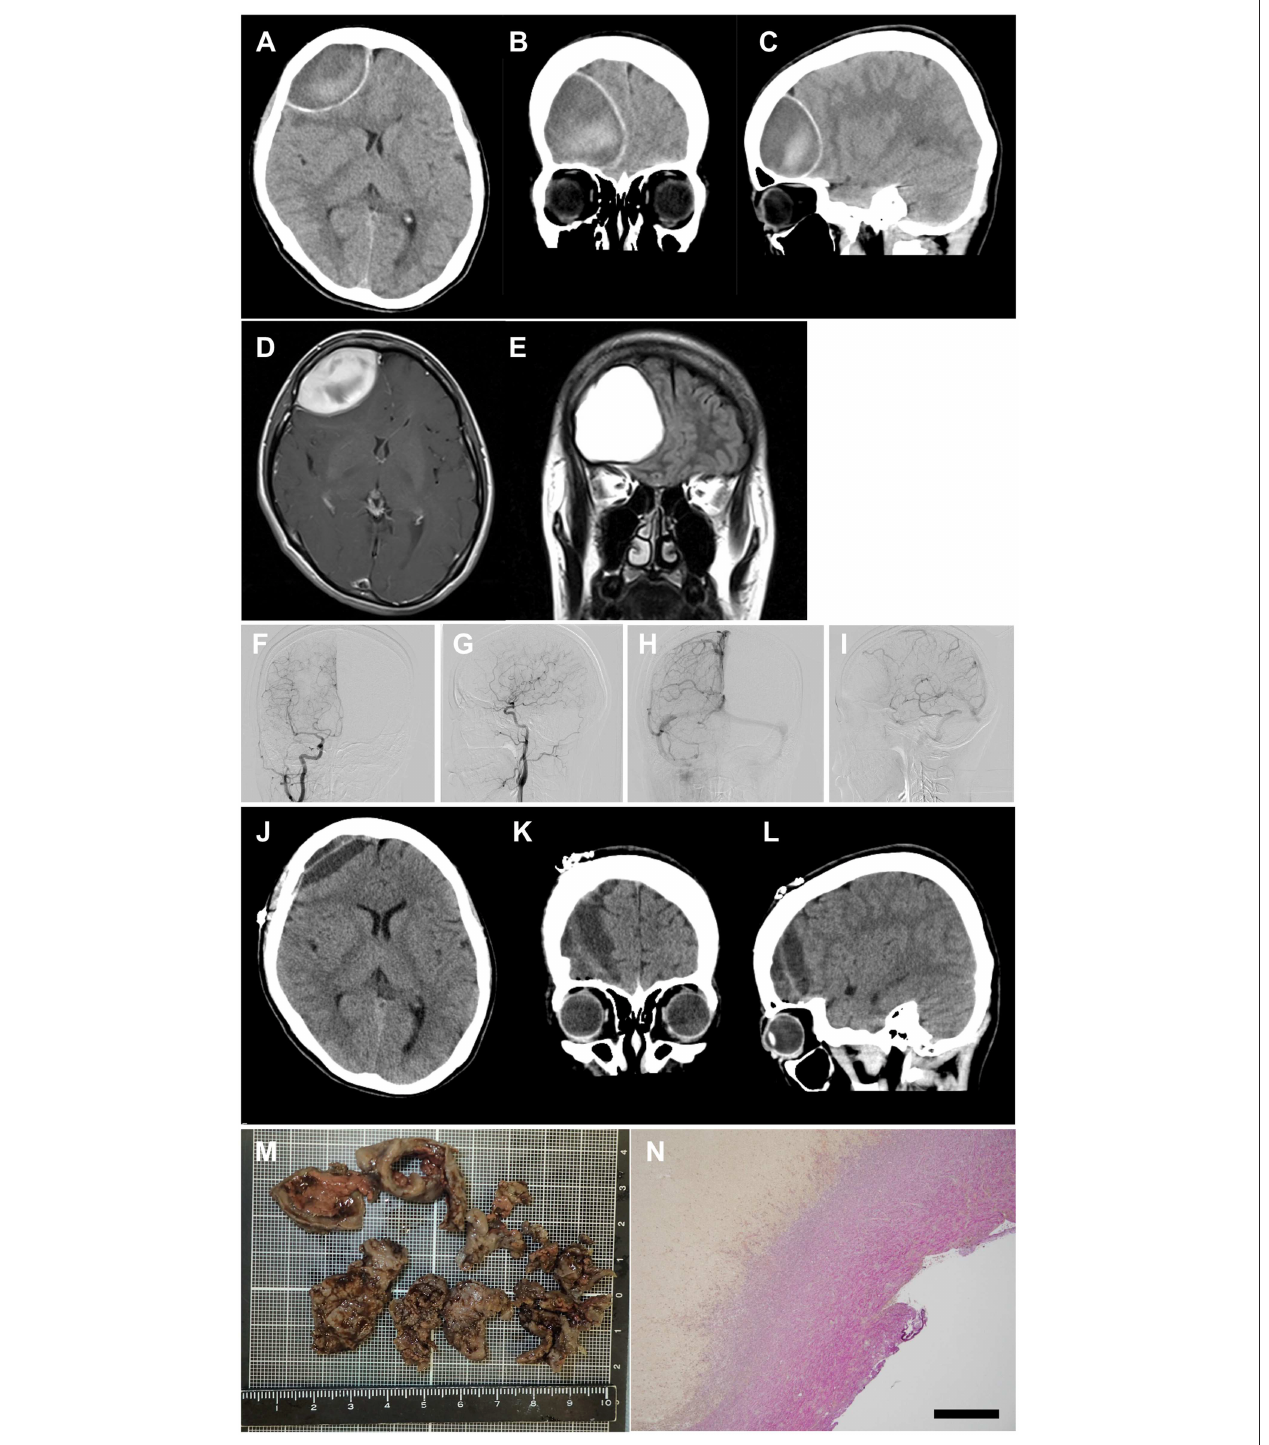
FIGURE 1 | Images of acute subdural hematoma. (A–C) CT scan images showing an acute epidural hematoma in the right frontal lobe with retraction of the lateral ventricle anterior horn and herniation of the falx cerebri. (D,E) post-contrast MRI images showing neither vascular malformation nor brain tumor. (F–I) cerebral angiography showing neither vascular malformation nor aneurysm [ (F,G) arterial phase; (H,I) venous phase]. (J–L) CT scan images obtained 7 days postoperatively showing successful removal of the hematoma. (M) macroscopic image of the removed hematoma. (N) microscopic image of the hematoma with Elastica van Gieson staining, demonstrating common pathological features of organized hematoma without vascular malformation or aneurysm. Scale bar, 500 µ m.